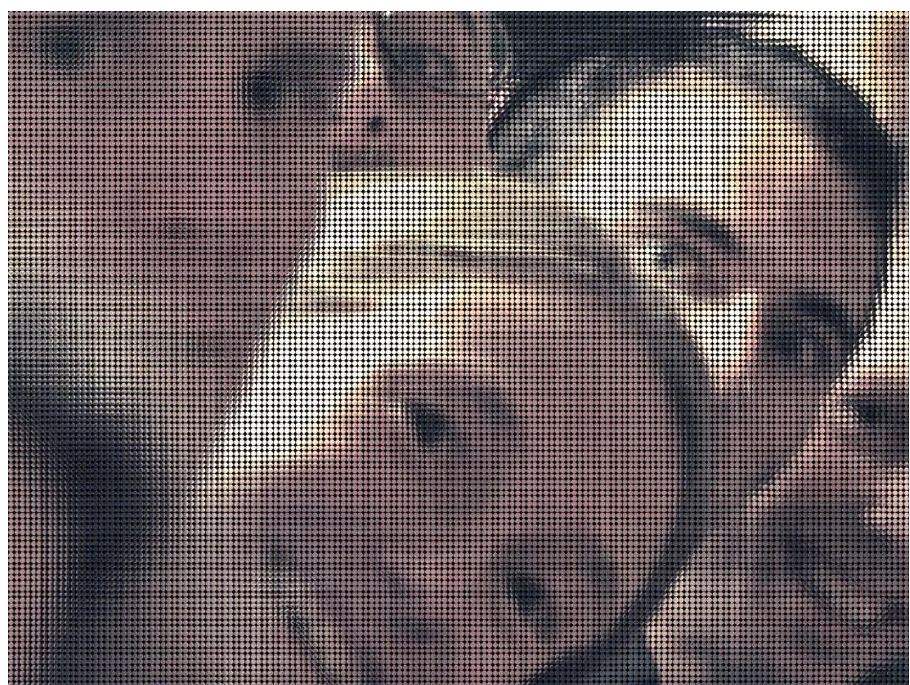
Figure 9. Lightfield captured with a plenoptic camera. Image taken from [5].